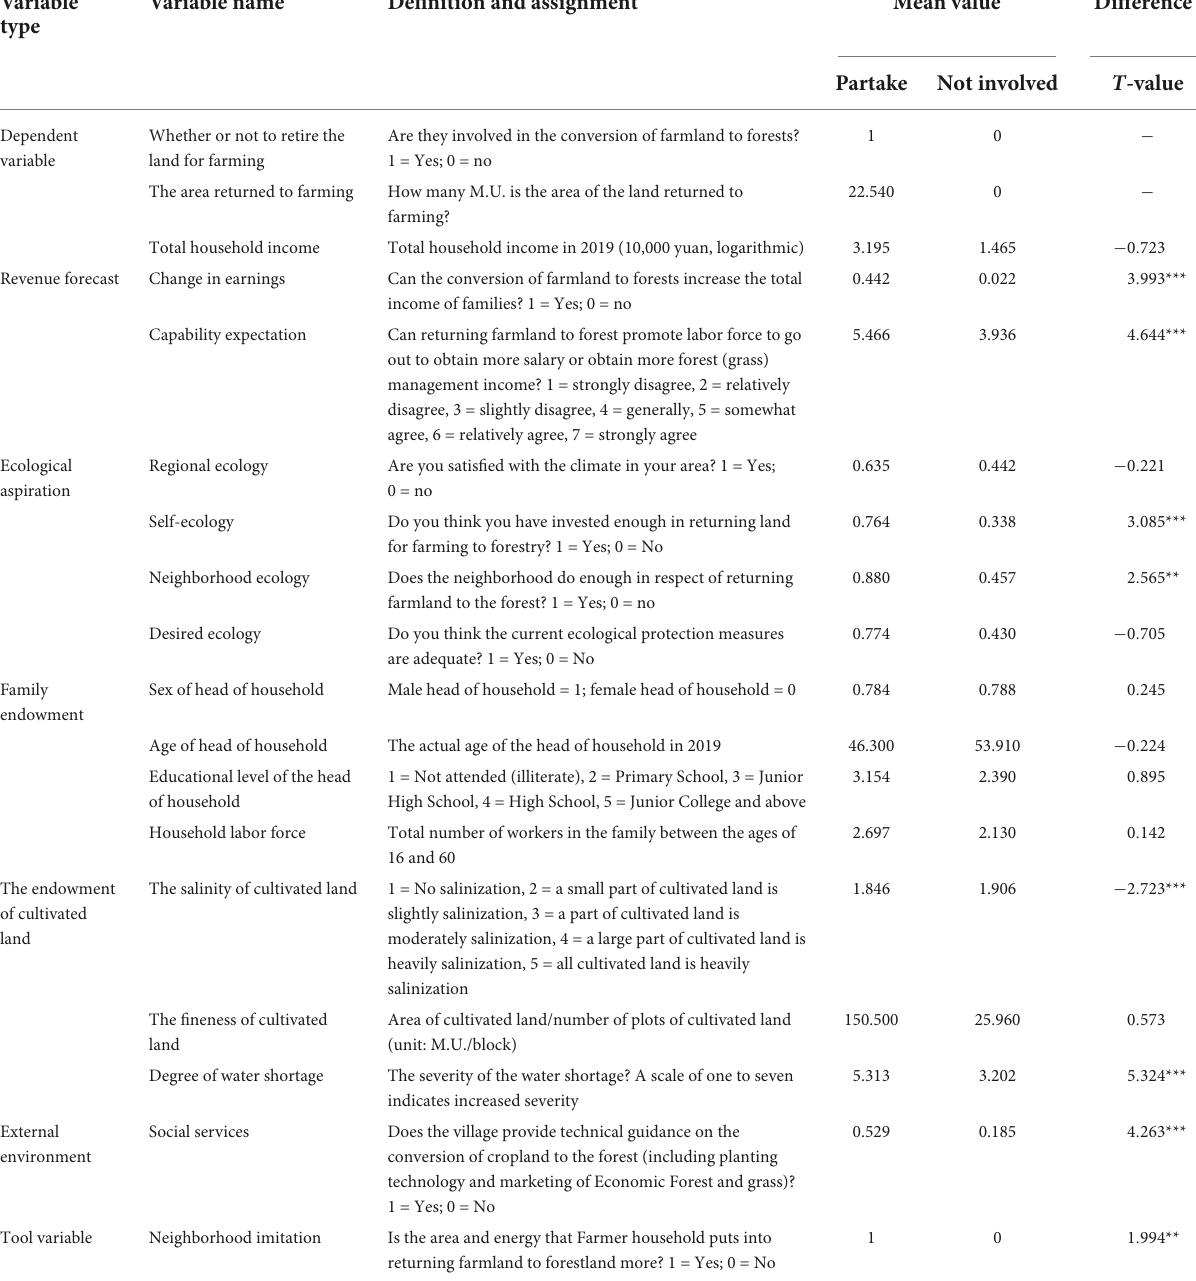
TABLE 2 Variable definition and descriptive